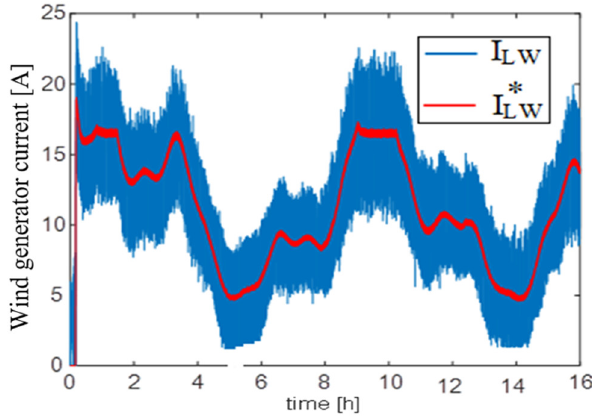
Figure 20. Control of the current wind generator, where I *Lw = I Lwref